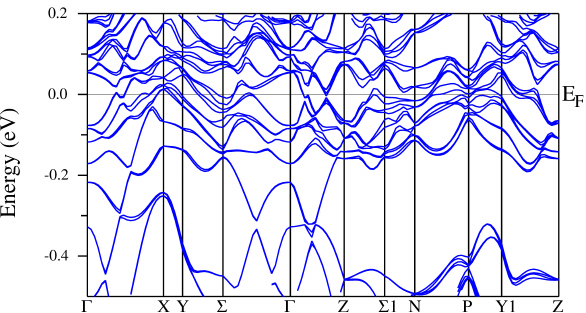
Figure 9. The band structure calculated along high-symmetry k lines in the Brillouin zone of Y 4.5 Sr 0.5 Rh 6 Sn 18 . The calculations were performed for U d = 3